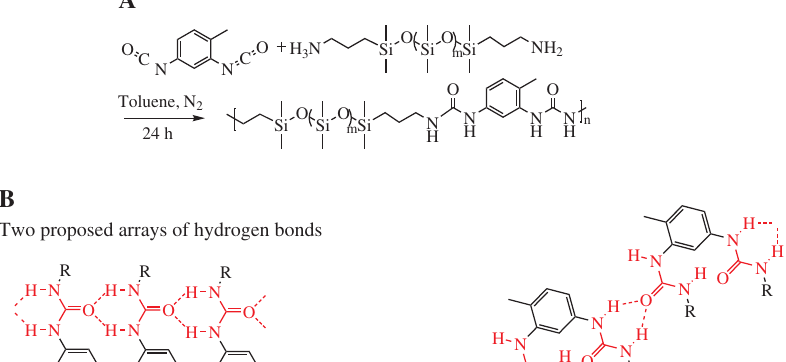
Figure 1: (A) The TEM image of the MAPbBr dispersed in toluene, Inset: photographs of the solutions for the MAPbBr absorption and PL spectra of the MAPbBr UV light of 365 nm and (D) Photograph of the stretched MAPbBr